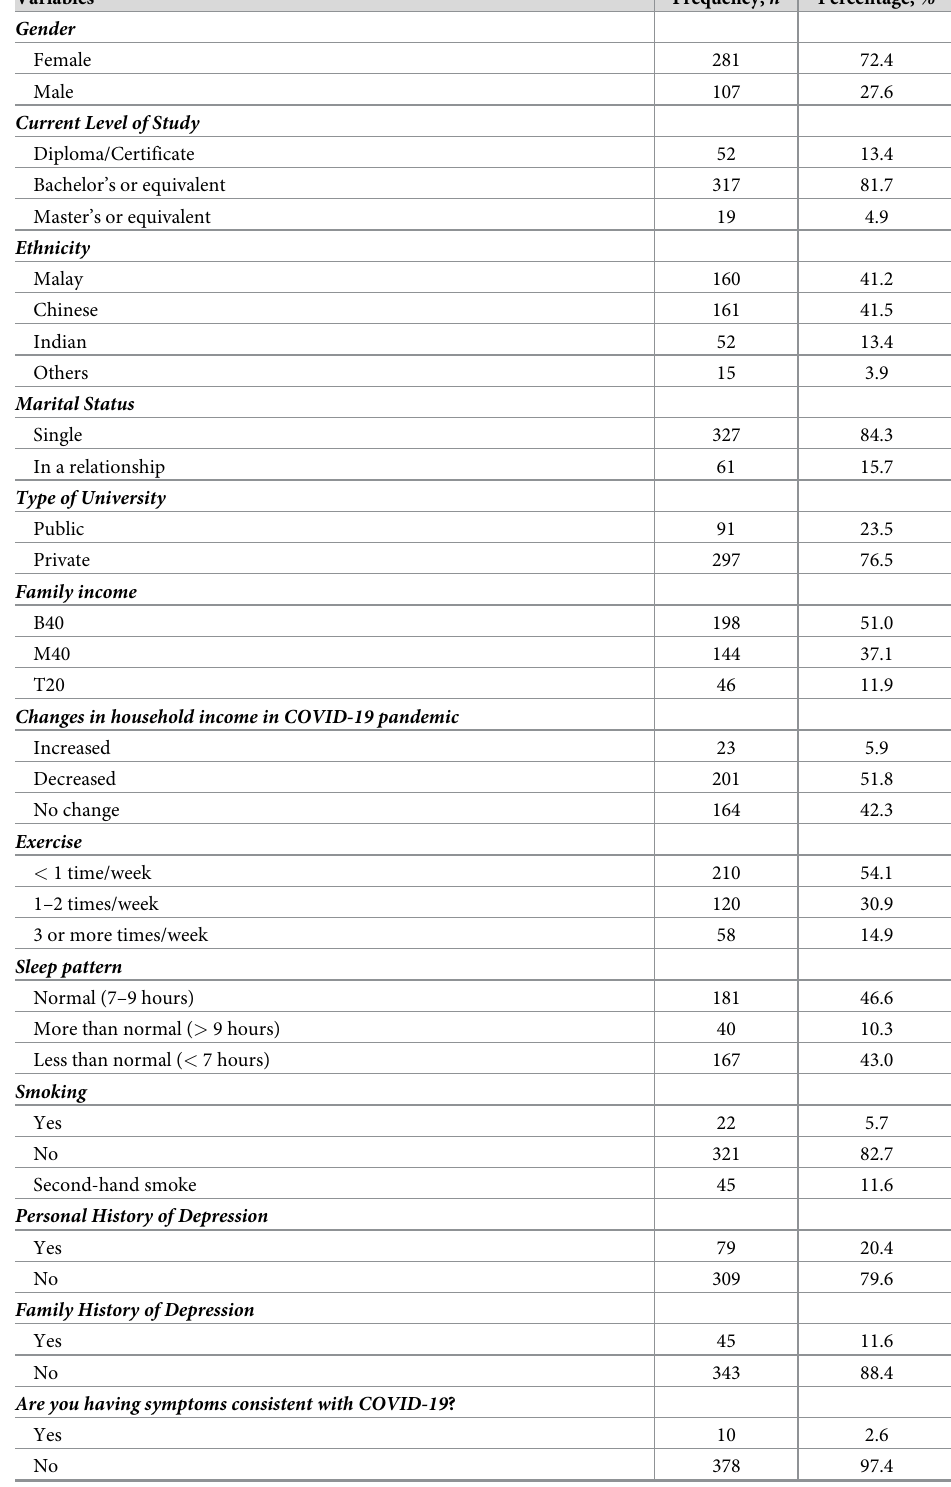
Table 1. Descriptive statistic of all independent